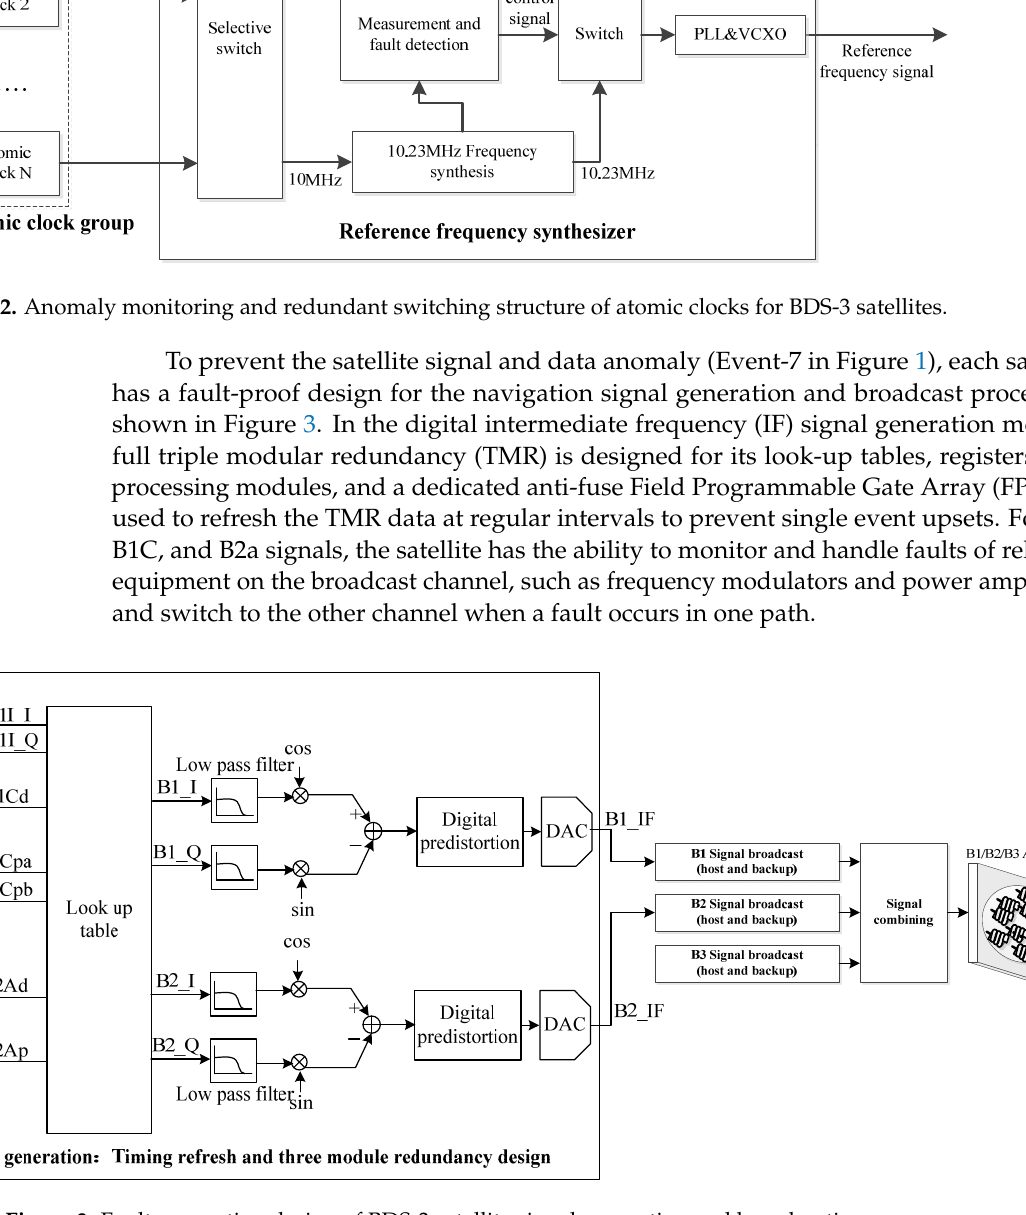
Figure 3. Fault prevention design of BDS-3 satellite signal generation and broadcasting.